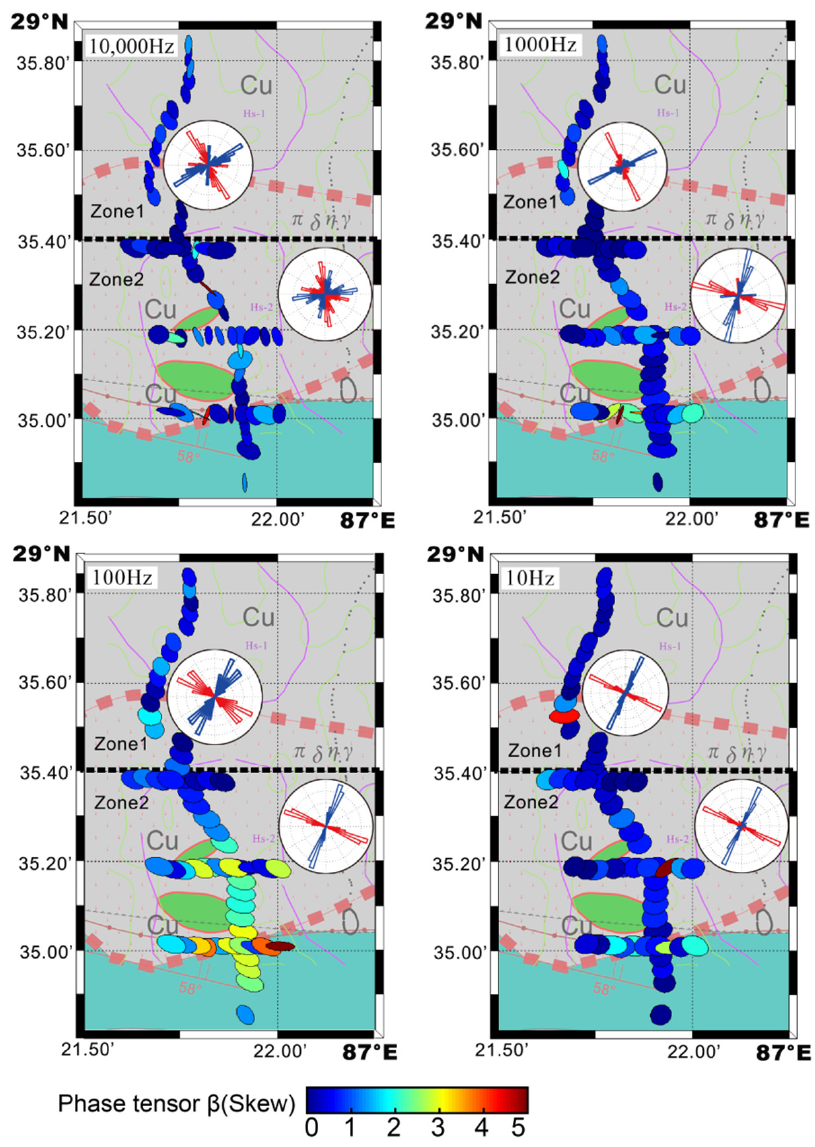
Figure 5. Geoelectric strike direction and dimensionality analysis of the AMT sites by period. The AMT sites are analyzed by two individual groups according to the location of the copper deposits. The red–blue sectors shown on the rose diagrams illustrate the inherent 90° ambiguity of the results of Groom-Baily decomposition [30]. The phase tensors [31] are represented by colored ellipses filled according to skew ( β angle) values.